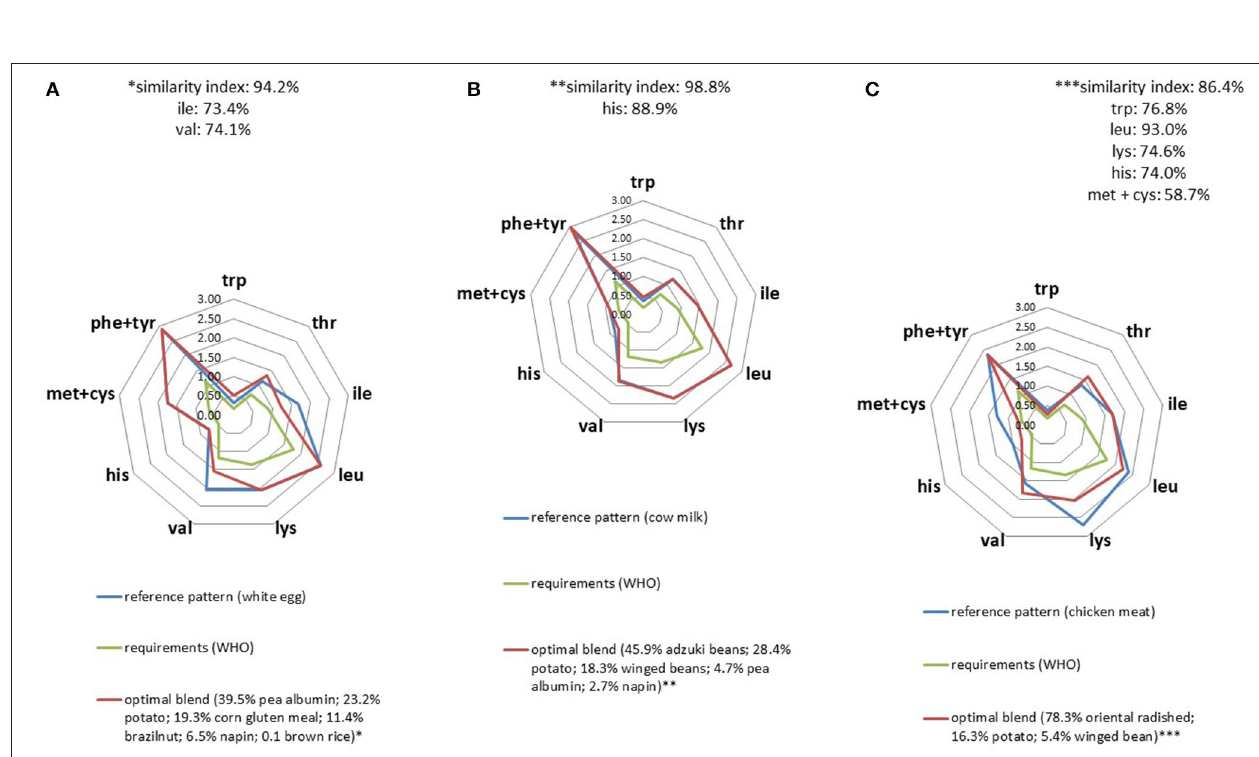
Frontiers in Nutrition |